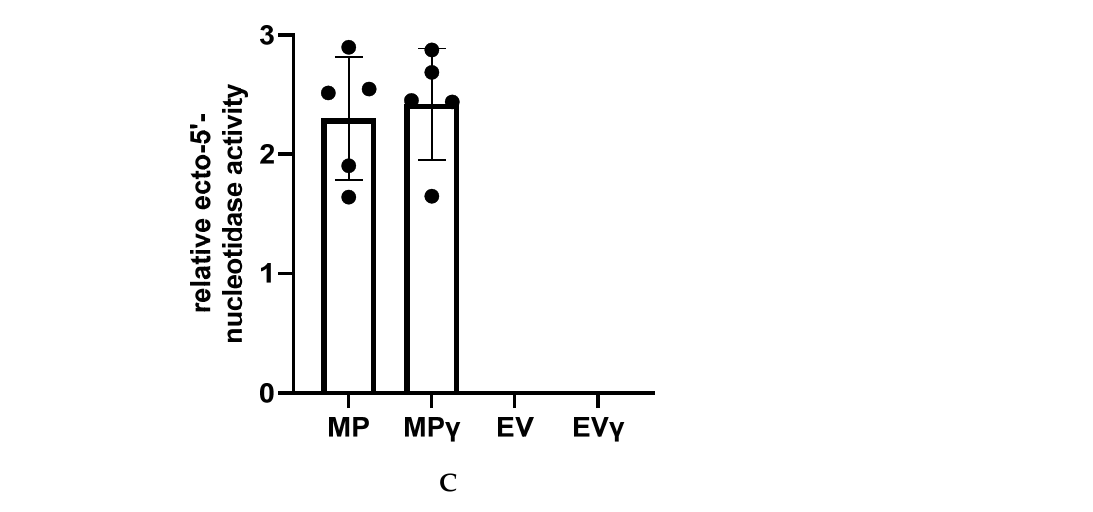
Figure 6. Enzymatic activity of EV and MP. ( A ): Relative abundance of 8 types of ATPases and ecto-5 ′ nucleotidase in EV, EV γ , MP and MP. ( B ): ATPase activity was measured at a concentration of MP and EV of 1 × 10 11 particles/mL. MP and MP γ catalyzed the breakdown of ATP at similar efficiency, whereas no activity was not observed for EV. ( C ): Ecto-5 ′ - nucleotidase activity was measured at a concentration of MP and EV of 1 × 10 11 particles/mL. MP and MP γ catalyzed the breakdown of AMP at similar efficiency, whereas no activity not observed for EV.